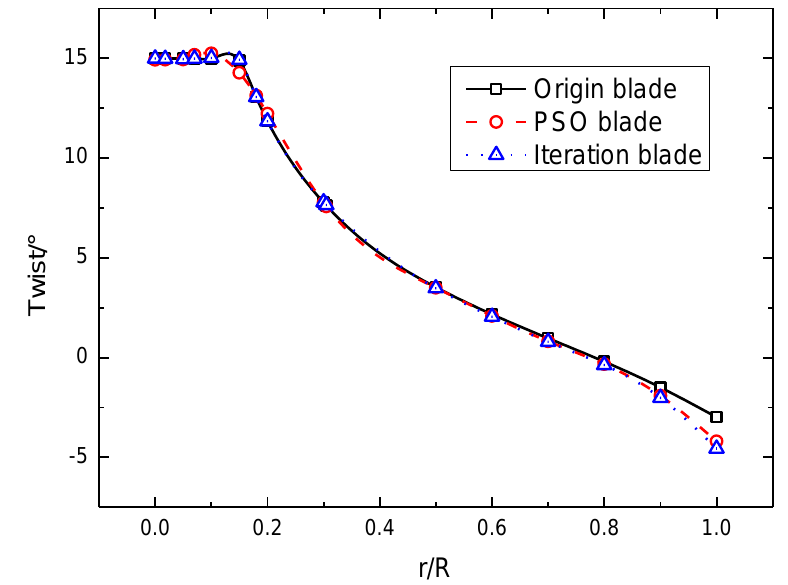
Figure 5. Twist distribution along the blade.